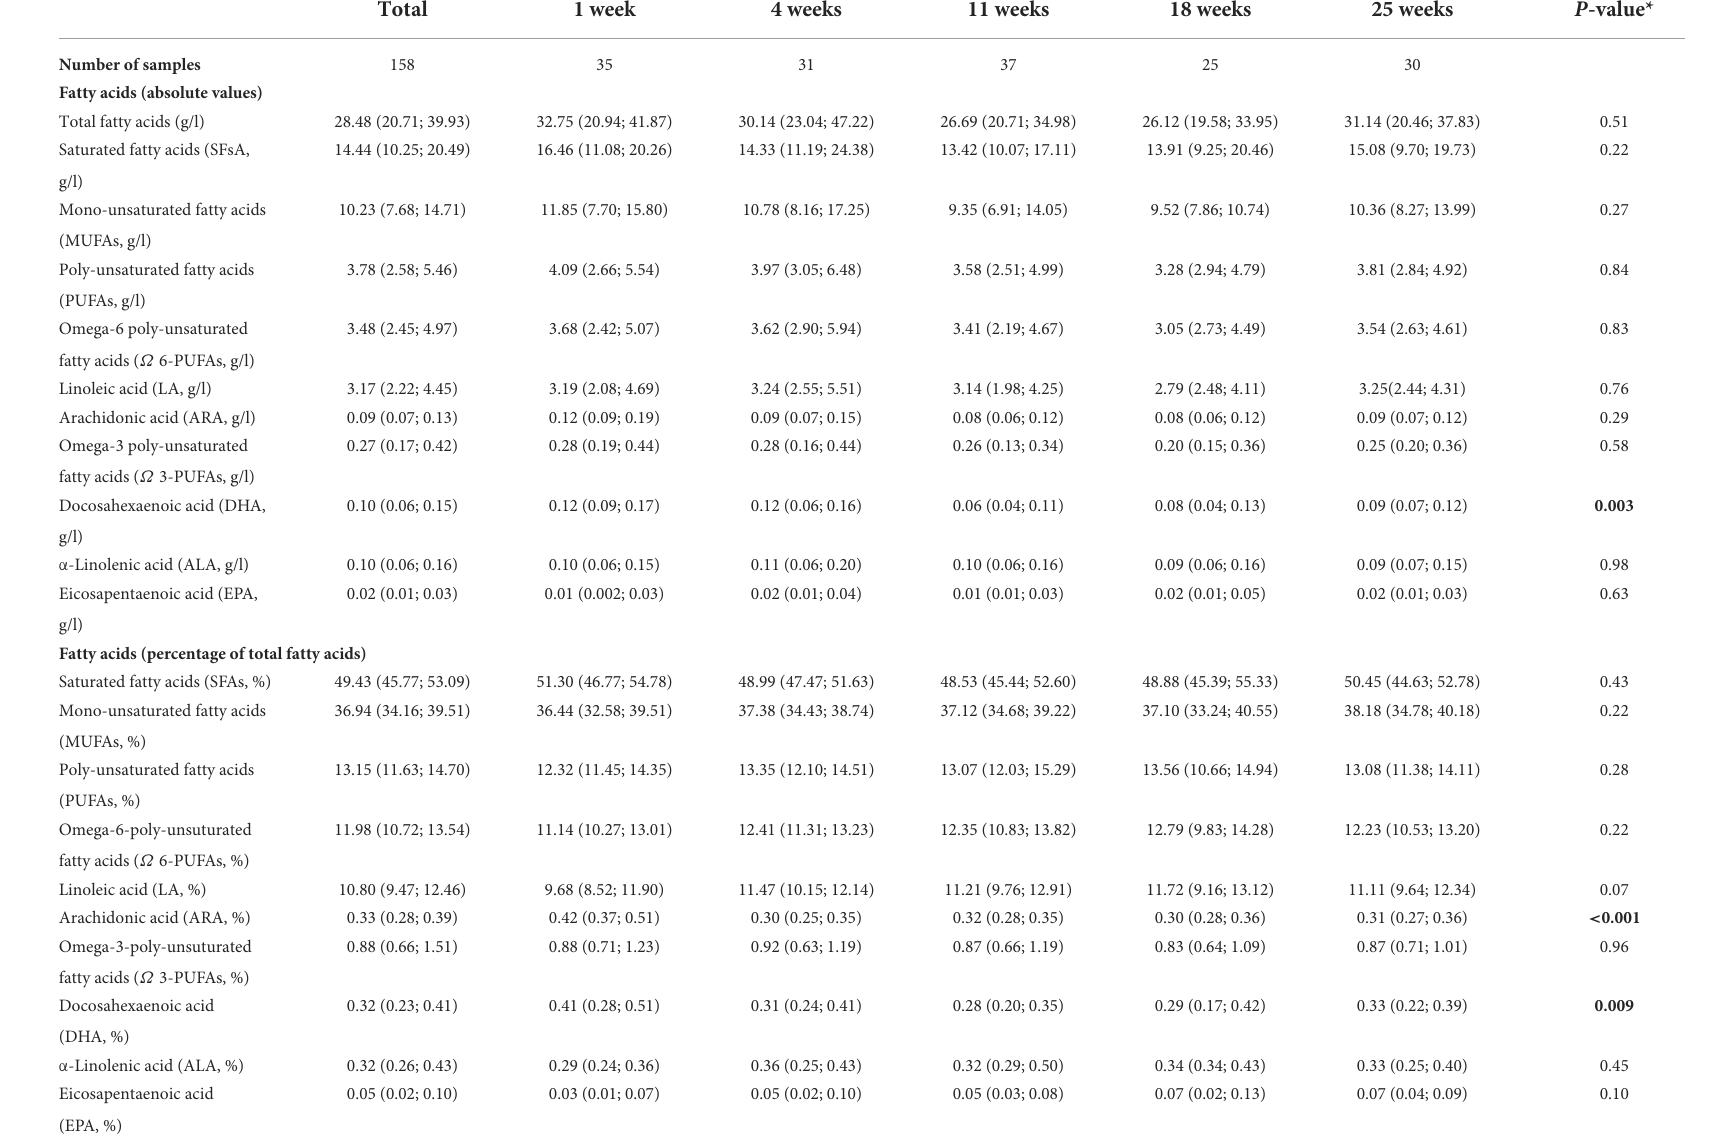
TABLE 3 Fatty acids in human milk during